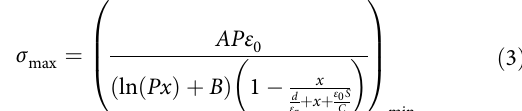
As depicted in Fig. 1f, with the decrease of dielectric thickness and